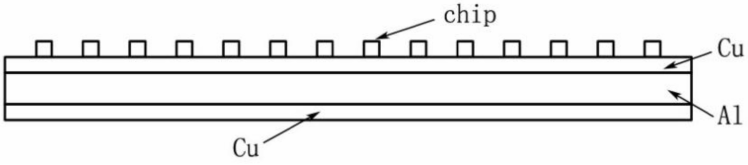
Figure 5. Schematic diagram of the composite